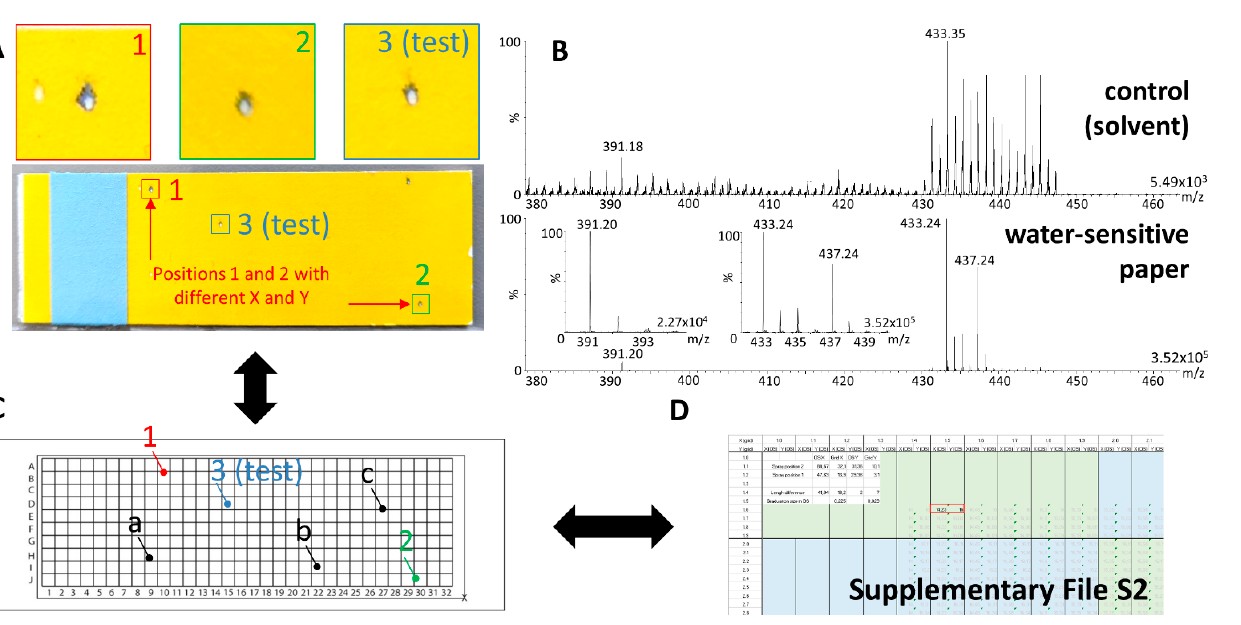
signal for a parent ion at m/z 433.24 and at m/z 391.19 for a fragment ion, as shown in Figure 8B. Water-sensitive paper was then also used for signal optimization, especially for the adjustment of X and Z positions of the motion plate that are relevant for optimum signal intensity, as described below. 4.8. Localization of x-y Positions in Omnispray The localization of the exact x-y position of sample spots is not intuitive because positions displayed by Omnispray are not reported physically on the x-y motion platform. On the other hand, variations in the position of the sprayer can change the position of the desorption beam, making it difficult to position the sprayer accurately in the direction of the x-y platform and thus the sample itself. In order to permit a fine positioning of the desorption beam, we created a grid that reports x-y positions displayed by Omnispray. The method relies on a teaching phase to correlate desorption areas with x-y positions displayed in Omnispray, using water-sensitive paper stuck on a histological glass slide (teaching slide). One teaching point was taken on the upper left corner (teaching point 1) and another on the lower right corner (teaching point 2) and the corresponding x-y position in Omnispray was noted (Figure 8A). The teaching slide was superimposed with a blank histological glass slide to mark the location of the teaching positions. This latter glass slide was overlaid with the grid provided in Supplementary File S1 and the coordinates for this grid were given (Figure 8C). Omnispray and grid coordinates from teaching points 1 and 2 were then documented in an Excel file as provided in